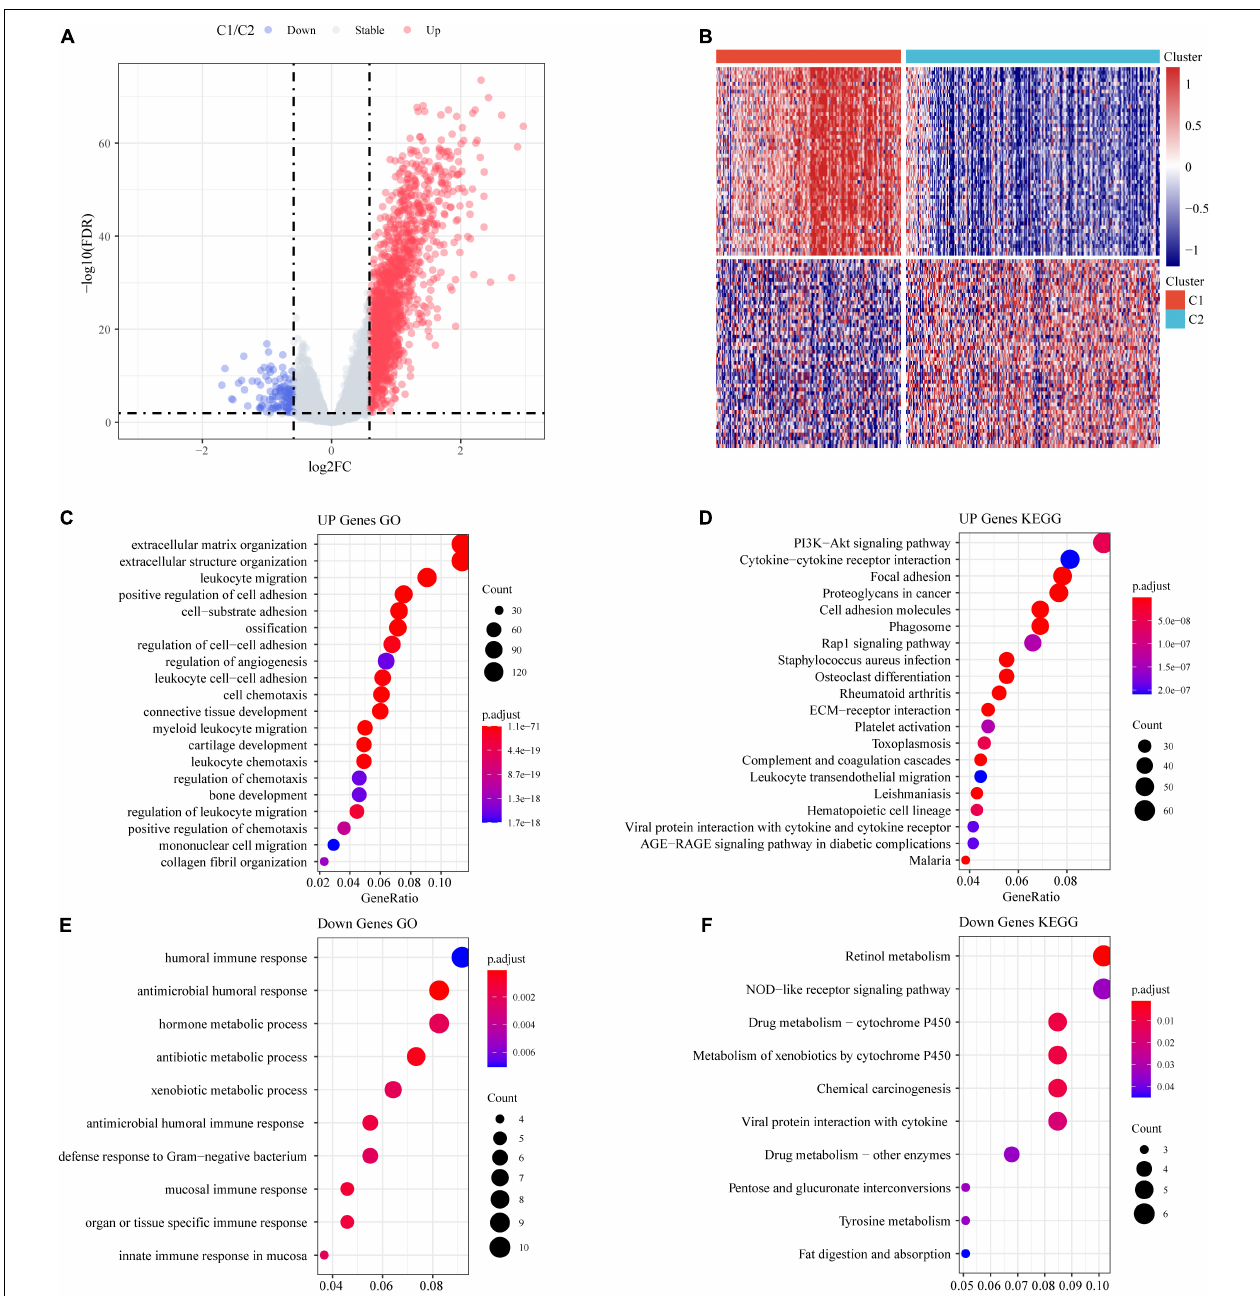
FIGURE 5 | Identification of differentially expressed genes (DEGs). (A) Volcano maps of DEGs. (B) Heatmaps of DEGs. (C) GO functional analysis of differentially upregulated genes. (D) KEGG functional analysis of differentially upregulated genes. (E) GO functional analysis of differentially downregulated genes. (F) KEGG functional analysis of differentially downregulated